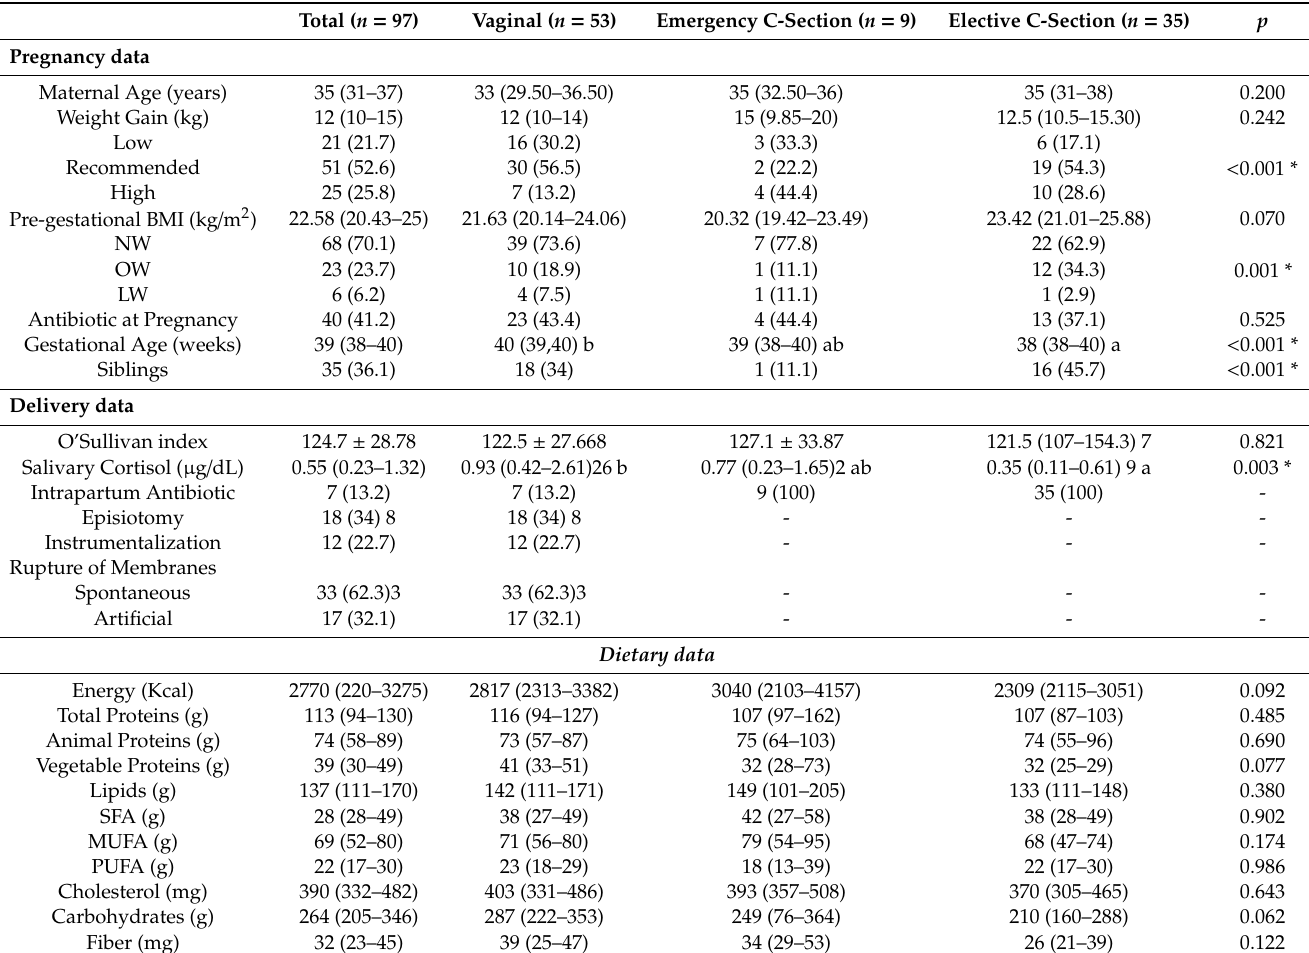
Table 1. Characteristics of the population in the microbiota study ( n =